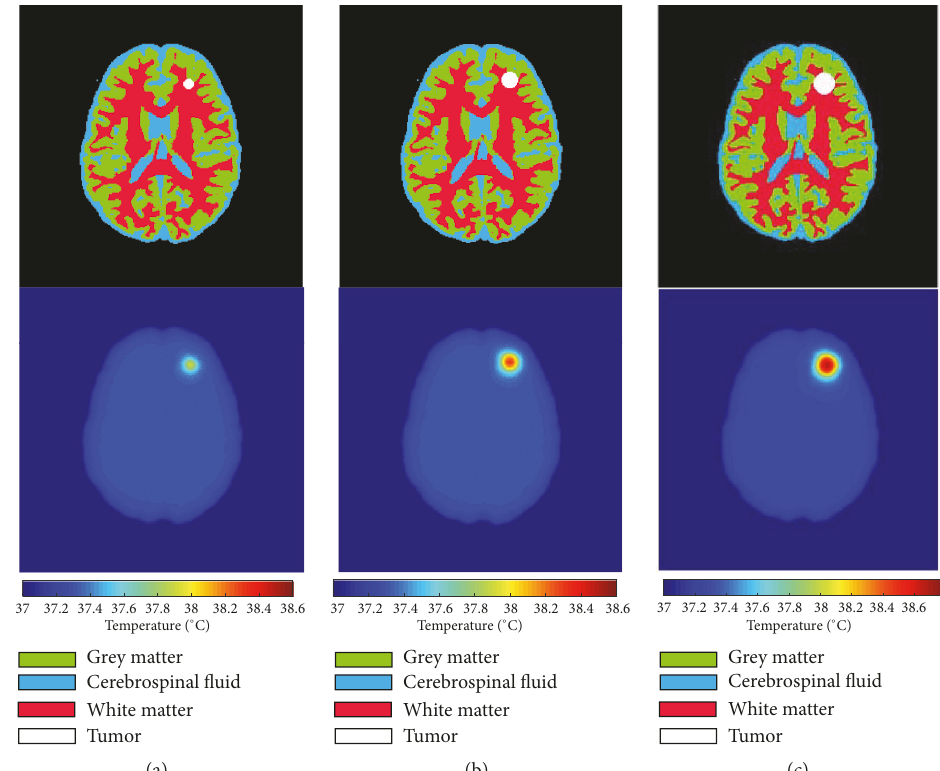
Figure 2: Temperature distribution of brain with circular tumors of three different diameters. (a) Tumor with 10 mm of diameter. (b) Tumor with 15 mm of diameter. (c) Tumor with 20 mm of diameter.